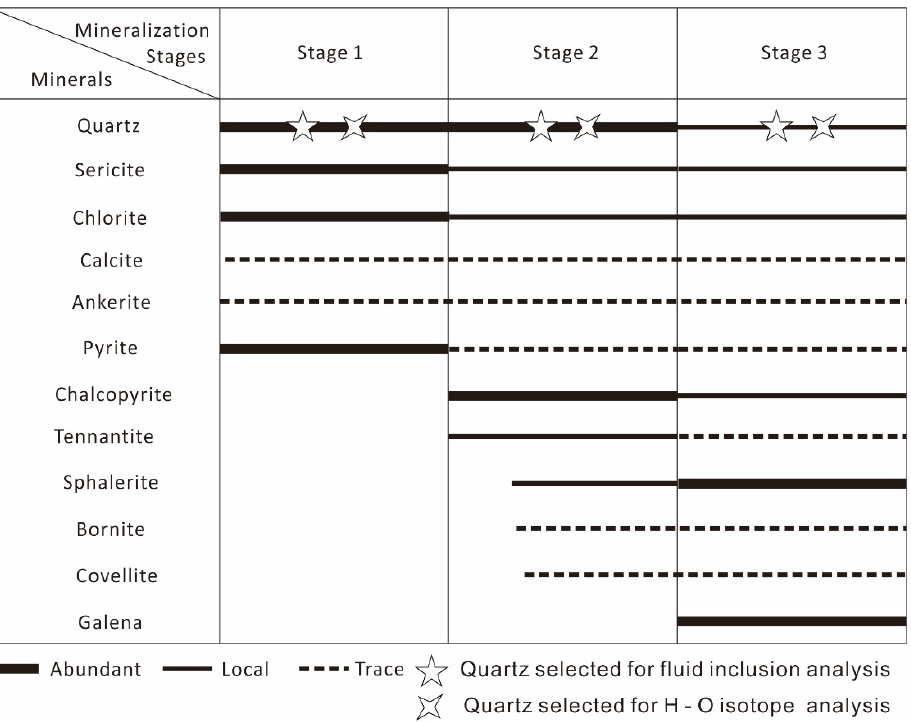
Figure 3. Photographs of orebody and hand specimens showing the mineralization and ore of the Xialiugou deposit. ( a ) Disseminated Fe ore body; ( b ) disseminated pyrite; ( c ) disseminated Cu ore body; ( d ) disseminated chalcopyrite–tennantite–sphalerite; ( e ) massive Pb–Zn ore body; ( f ) layered galena, sphalerite and chalcopyrite. Py = Pyrite; Ccp = Chalcopyrite; Sp = Sphalerite; Gn = Galena. Yellow dashed lines offer demarcation of the ore body within the wallrock or strata.